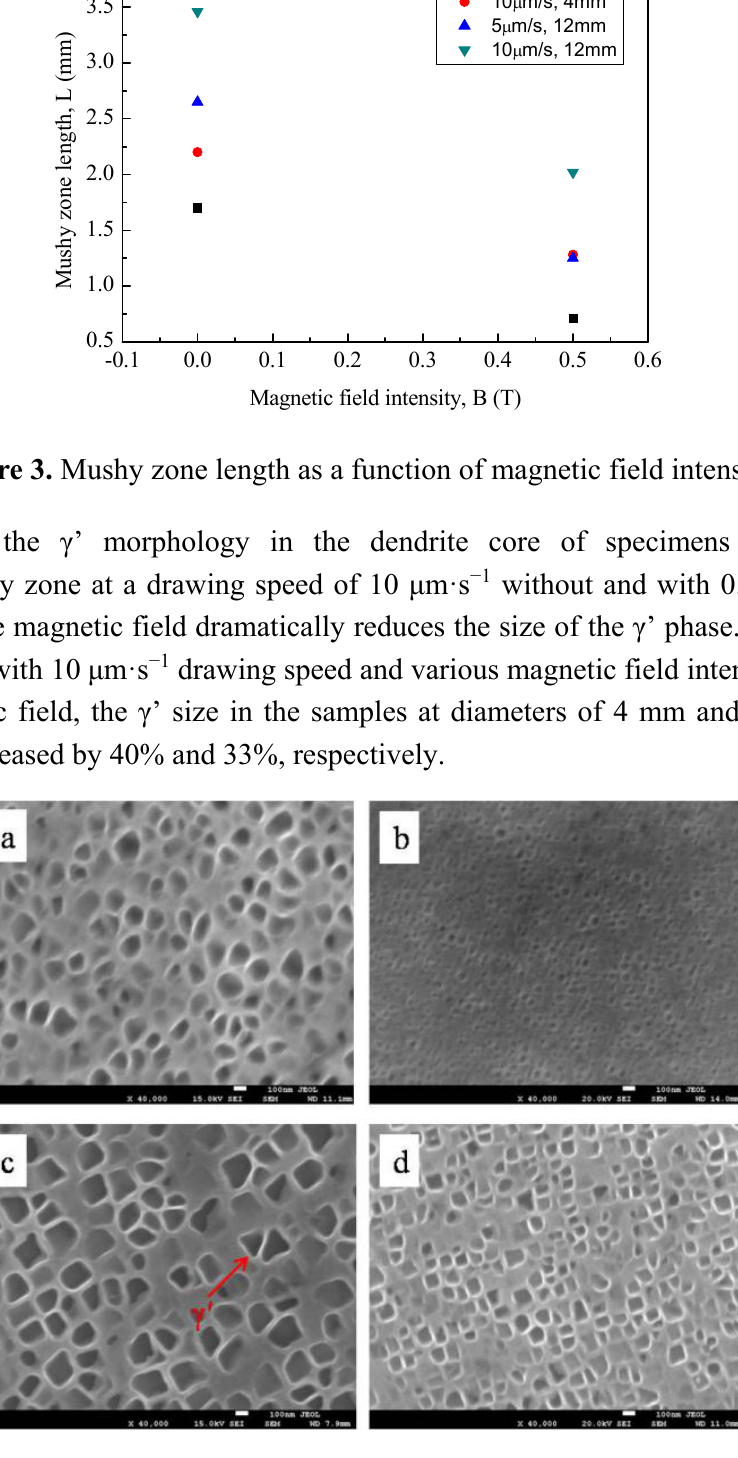
Figure 4. The morphology of γ ’ of directionally solidified superalloy at a temperature gradient of 80 K·cm − 1 , drawing speed of 10 μ m·s − 1 : ( a ) 0 T, diameter of 4 mm; ( b ) 0.5 T, diameter of 4 mm; ( c ) 0 T, diameter of 12 mm; ( d ) 0.5 T, diameter of 12